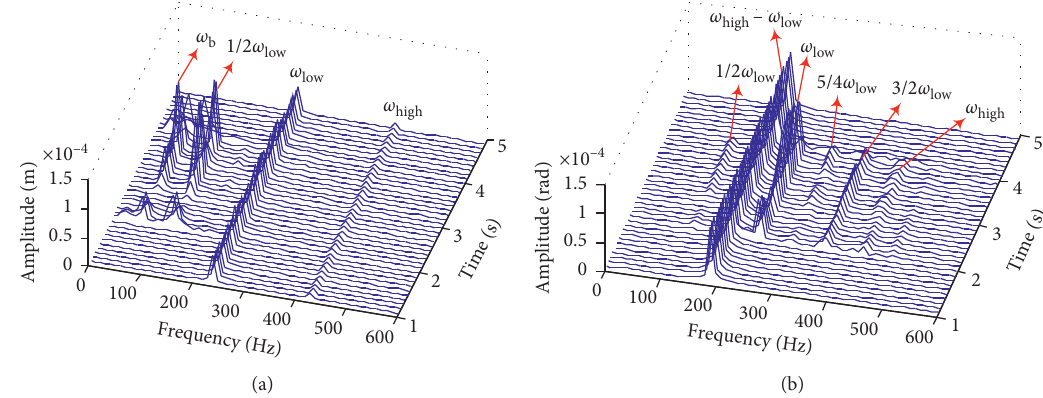
Figure 11: Transient time-frequency waterfall curves of the bending and torsional motions of the rotor system for kr � 8 × 106N/m. (a) Bending motion and (b) torsional